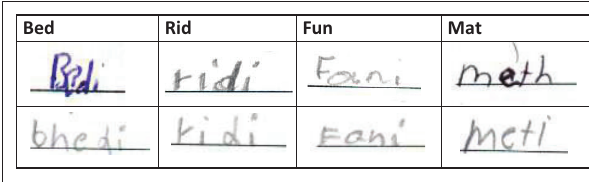
FIGURE 5: LI to L2 transfer (language interference).